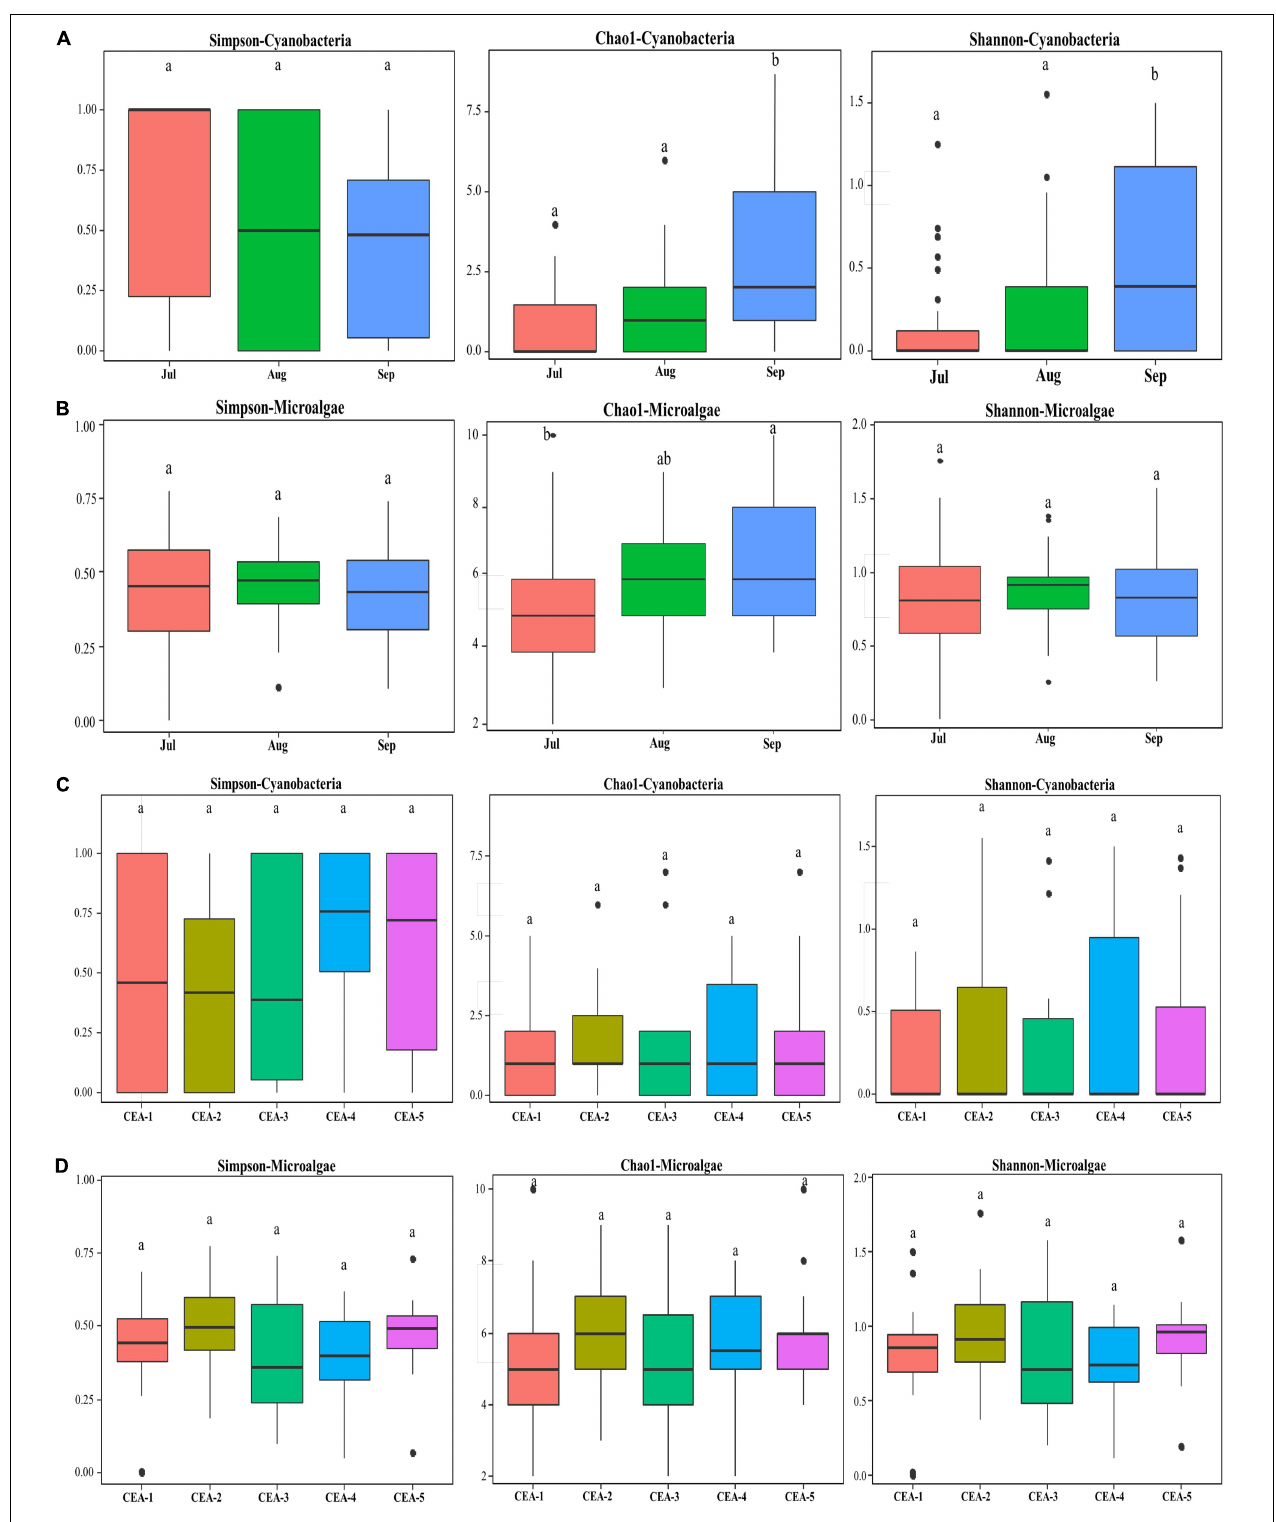
FIGURE 5 | Box plots for diversity and richness indices of the cyanobacterial and microalgae communities in different months and sampling sites. (A) Cyanobacterial communities by sampling month. (B) Microalgae communities by sampling month. (C) Cyanobacterial communities by sampling site. (D) Microalgae communities by sampling